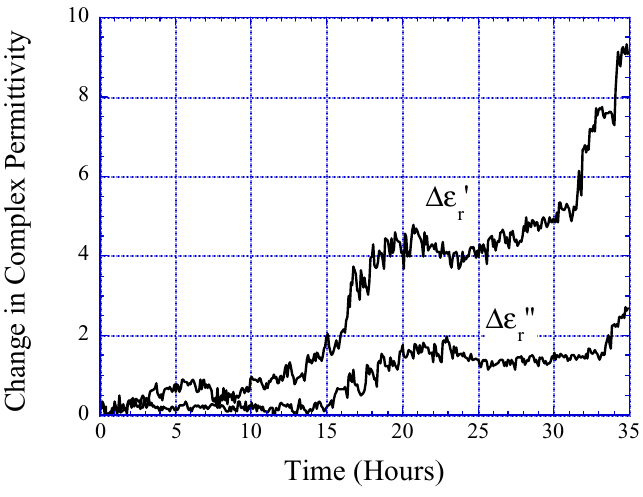
Figure 9. The experimental setup for meat quality monitoring. The sensor is placed between the meat and the wall of the Styrofoam package